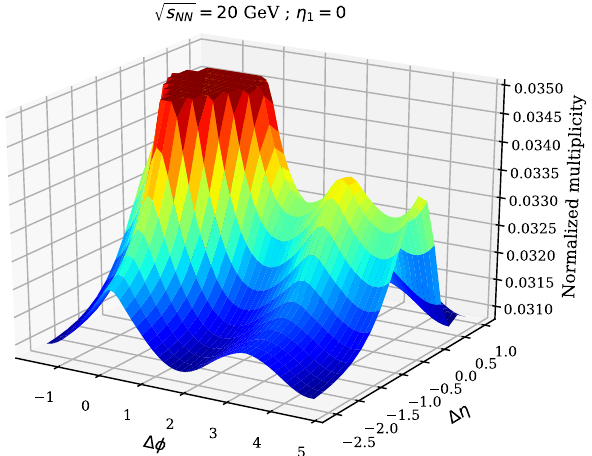
Fig. 7 Dependence of the normalized multiplicity with respect to the azimuthal angle and the rapidity difference. In order to make the non- eikonal effects more visible, we have cut the near-side peak for values larger than 0.0345